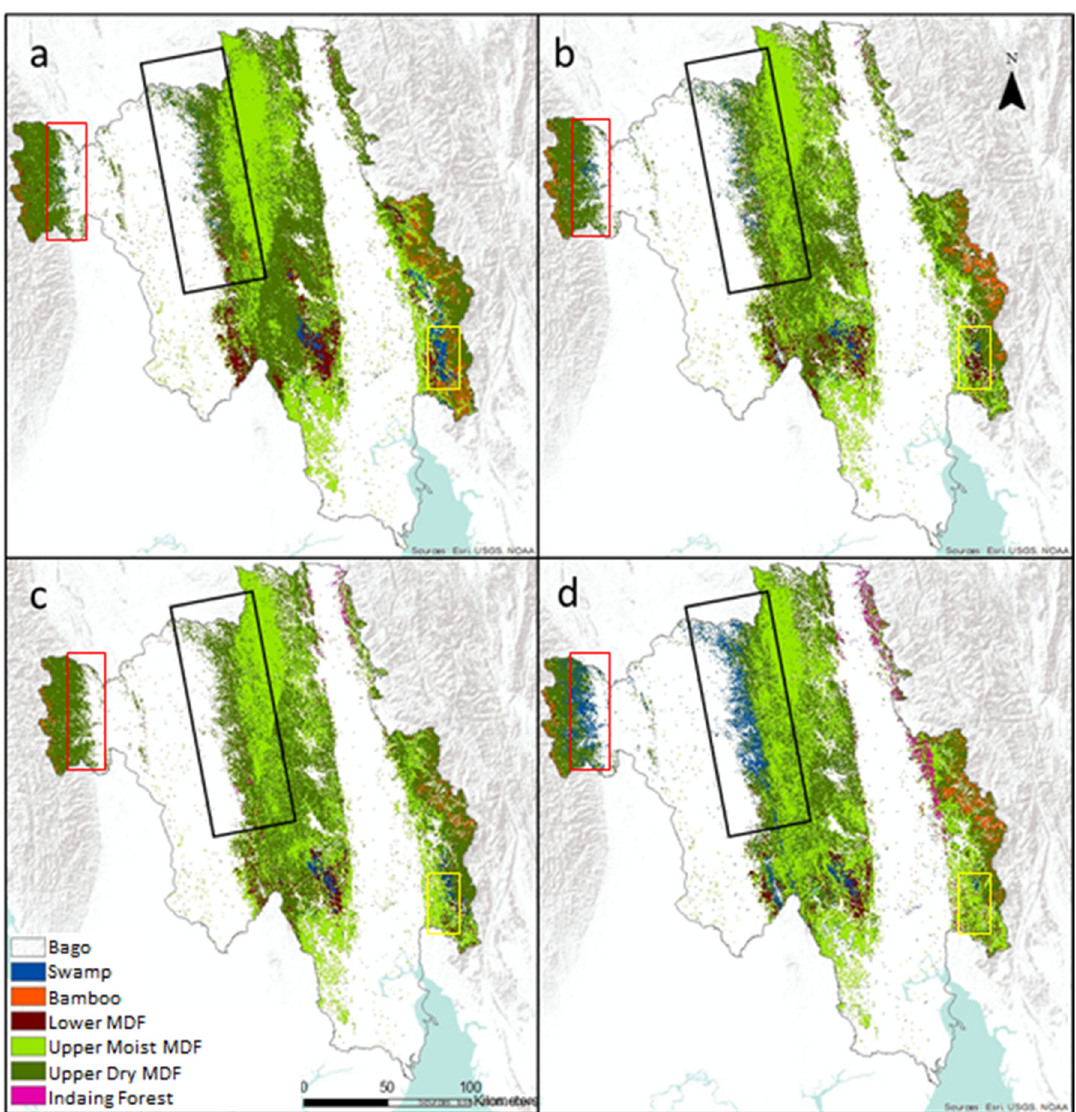
Figure 4. Comparison of the forest type maps for the Bago Region of Myanmar, based on different combinations of satellite data and derived variables. The black, red and yellow boxes show areas of disagreement. ( a ) Landsat-8 Model, ( b ) Sentinel-2 with Landsat-8 like bands Model, ( c ) Sentinel-2 all bands Model, ( d ) Sentinel-1 and -2 Model.